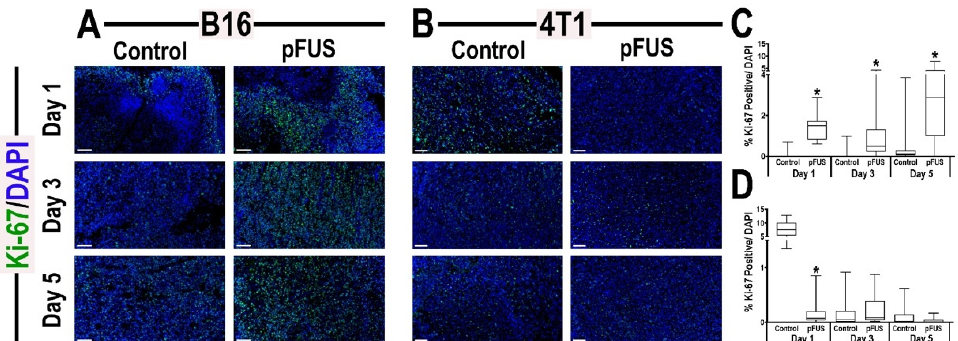
Figure 6. Representative images of Ki-67 localization within sectioned ( A ) B16 melanoma or ( B ) 4T1 breast flank tumor sections 1 (top), 3 (middle), or 5 (bottom) days following pFUS treatment (right) or untreated control tumors (left) ( n = 6 sections/tumor type/time point). Quantitative analysis of Ki-67 localization within ( C ) B16 tumors or ( D ) 4T1 tumor area. The upper and lower bounds of the boxplots denote the 25th and 75th percentiles, while the midlines indicating the mean values. Whiskers indicate values outside the upper/lower quartile and within standard deviations. Asterisks indicate statistical significance ( p < 0.05; unpaired t -test) between tumor-bearing mice treated with pFUS to time-matched untreated controls. (scale 100 μ m).